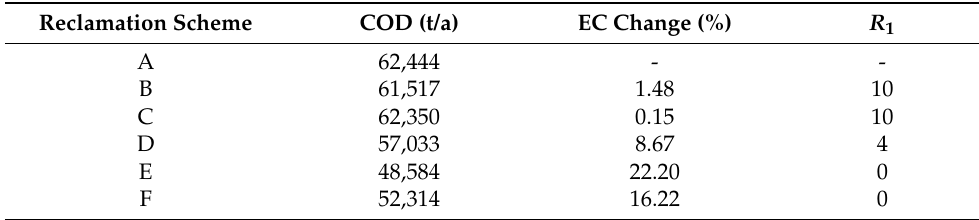
Table 19. Feasibility evaluation of COD environmental